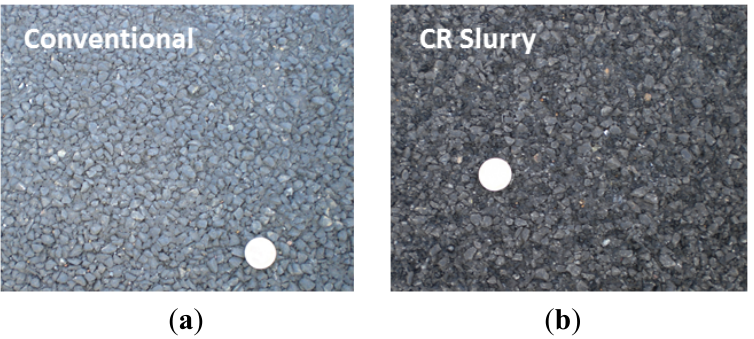
Figure 2. Representative photographs of the bituminous slurry wearing courses conventional ( a ) and experimental with crumb rubber ( b